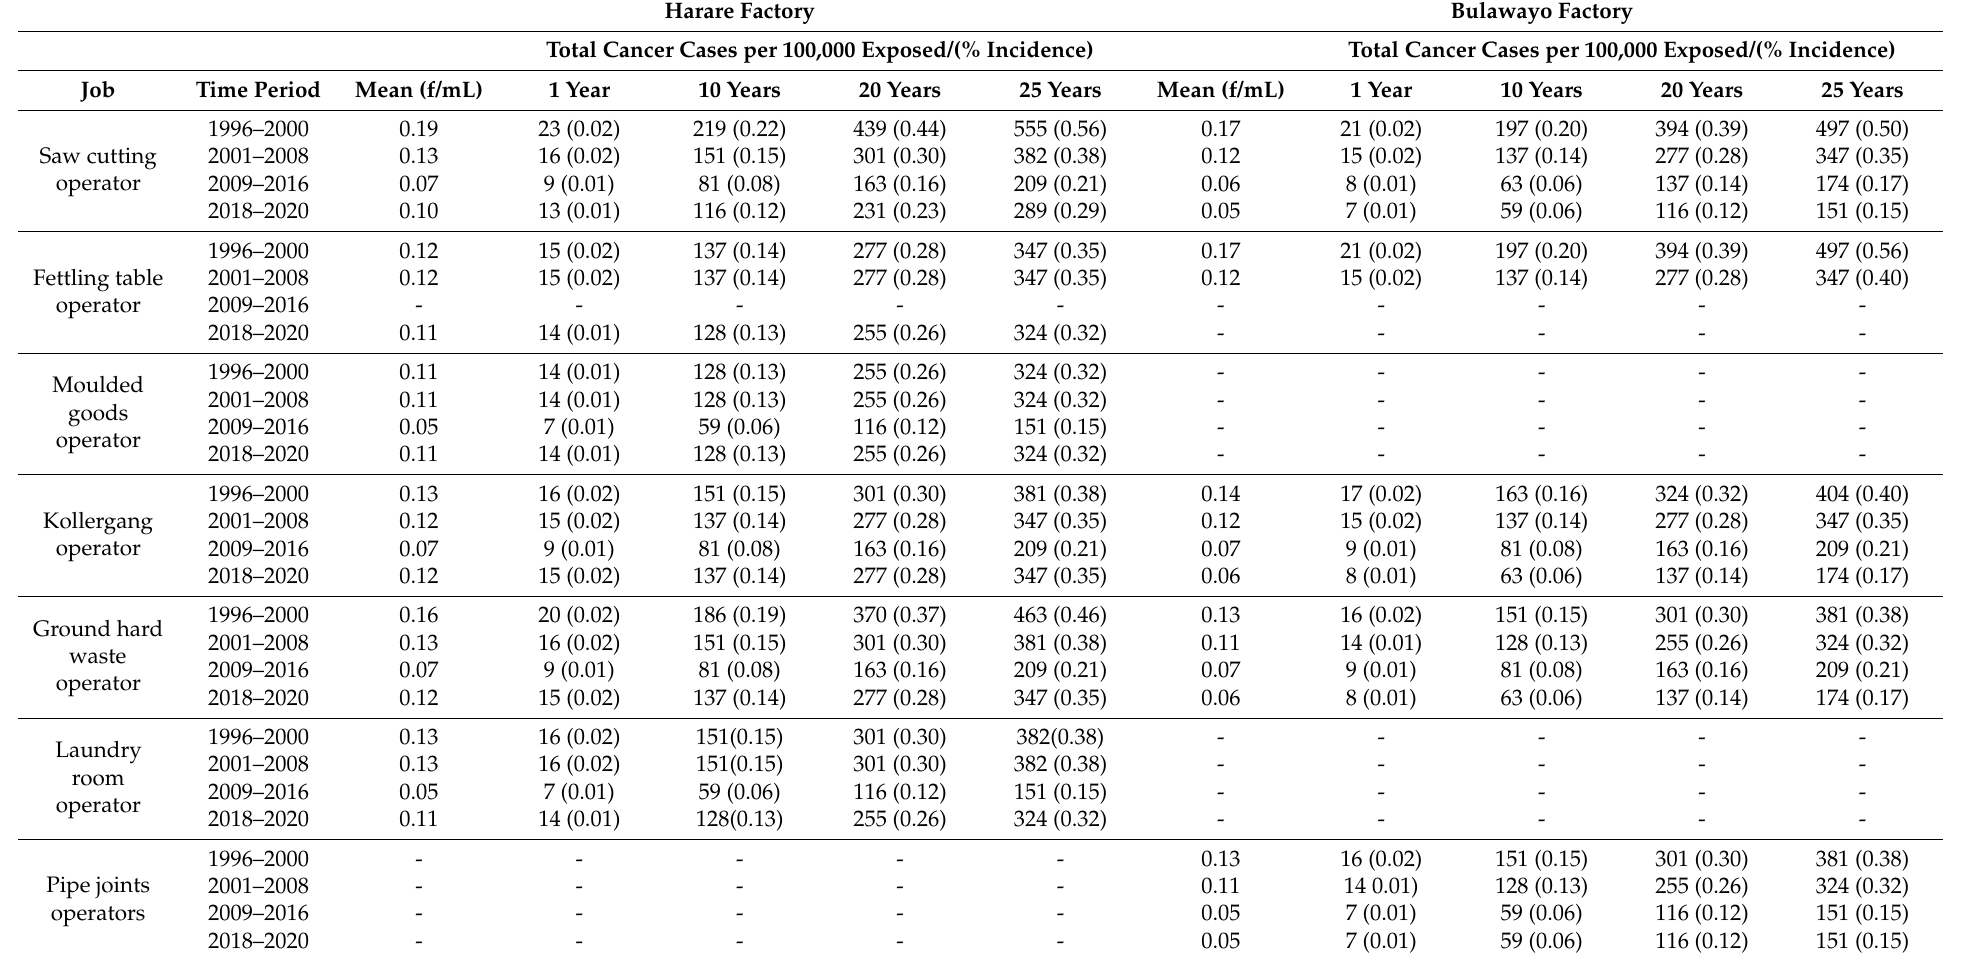
Table 3. Estimates of the summary of total cancer mortality cases by job and time